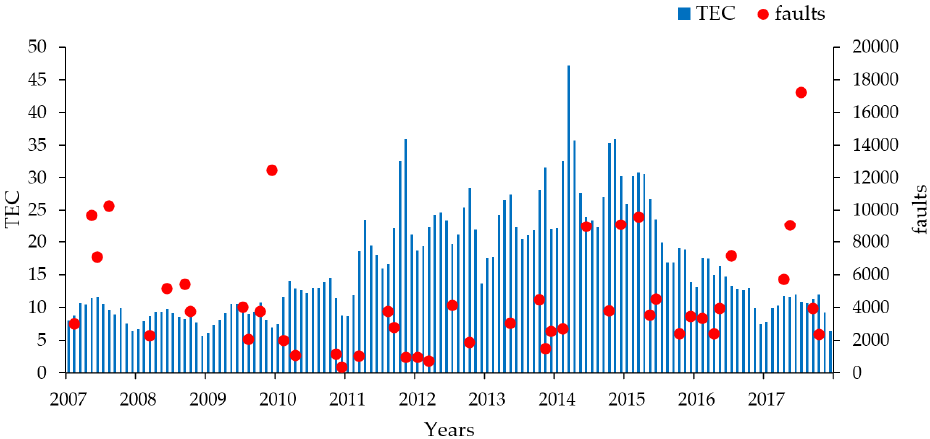
Figure 15. Monthly average of daily maximum TECs and the average number of faults per month. Figure 15 indicates the monthly average of the irregularities of daily maximum TECs and the average number of faults per month. Figure 16 shows the monthly mean values